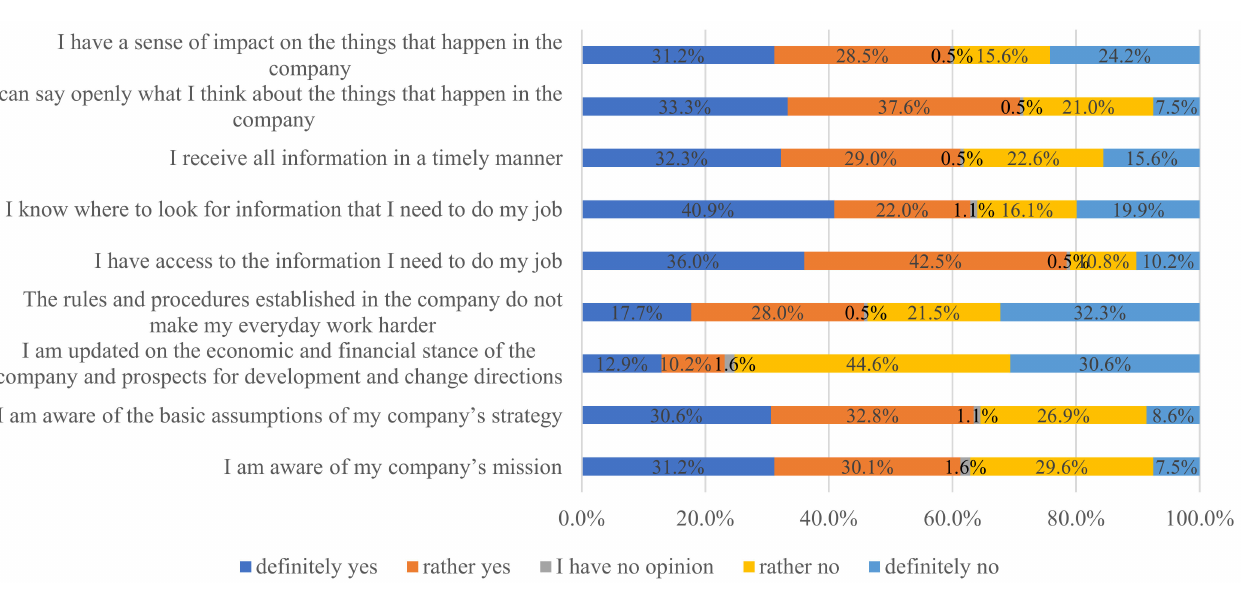
Figure 4. Assessment of the impact of communication processes on the opportunities to generate and implement new solutions in the company. Source: Own